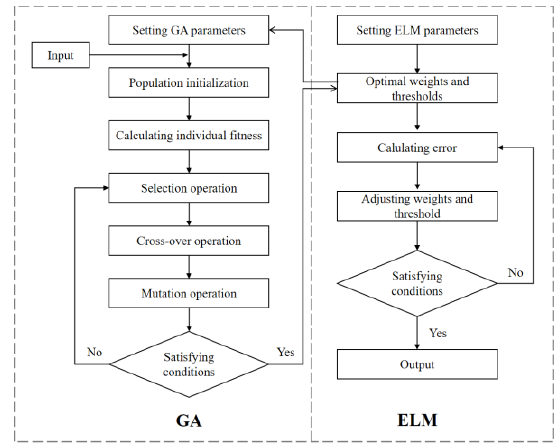
Figure 3. The flowchart of Figure 3 . The flowchart of GA-ELM.